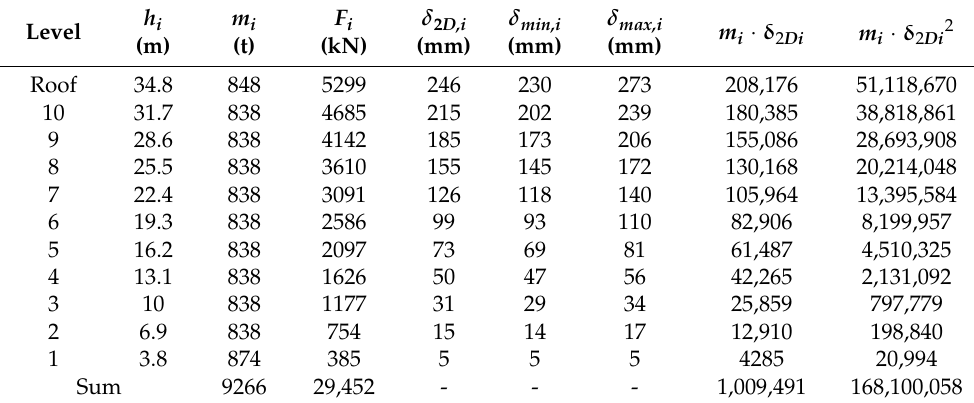
Table A2. Detail of the storey height ( h i ), storey mass ( m i ), and equivalent static storey design forces ( F i ) of the case study building 1 (CSB